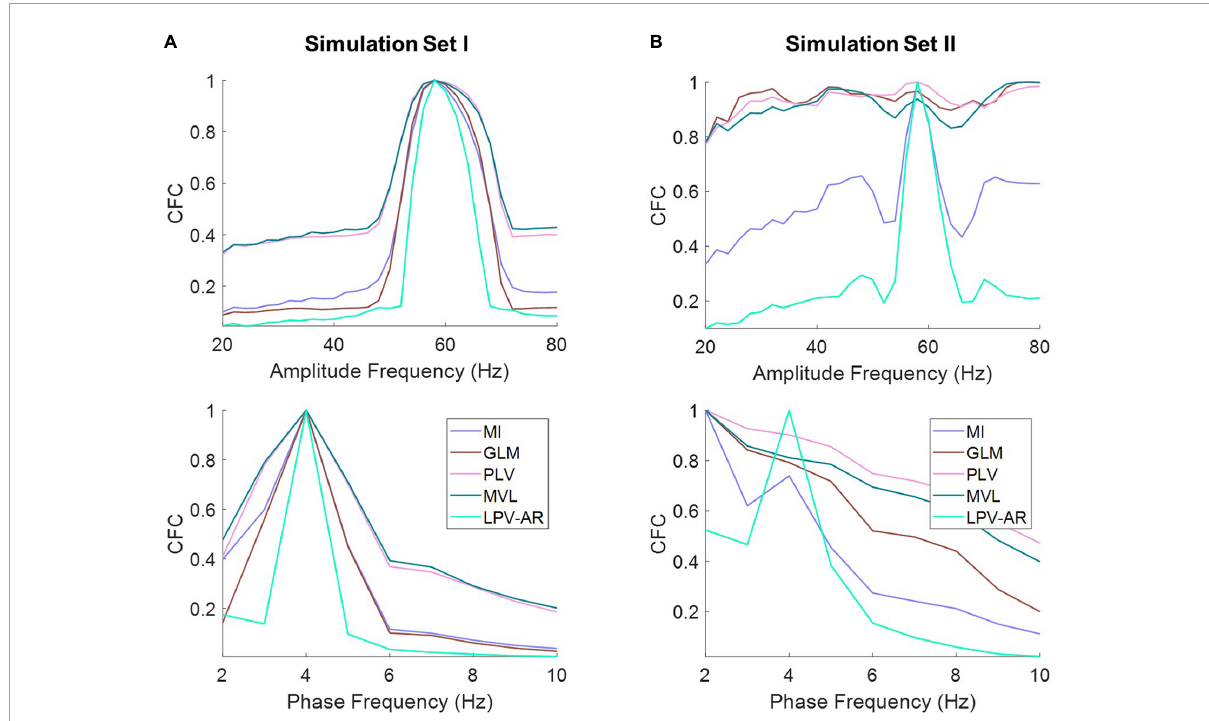
FIGURE5 The average of the comodulograms depicted in Figure 4 for (A) simulation set I and (B) simulation set II along the amplitude (top panels) and the phase frequencies (bottom panel) for different CFC methods (normalized to their maximum value). The LPV-AR technique exhibits higher resolution in detecting CFC (i.e., higher CFC at f L = 4 Hz and f H = 60 Hz and lower sidebands around these frequencies) and lower bias in frequencies where no coupling exists.